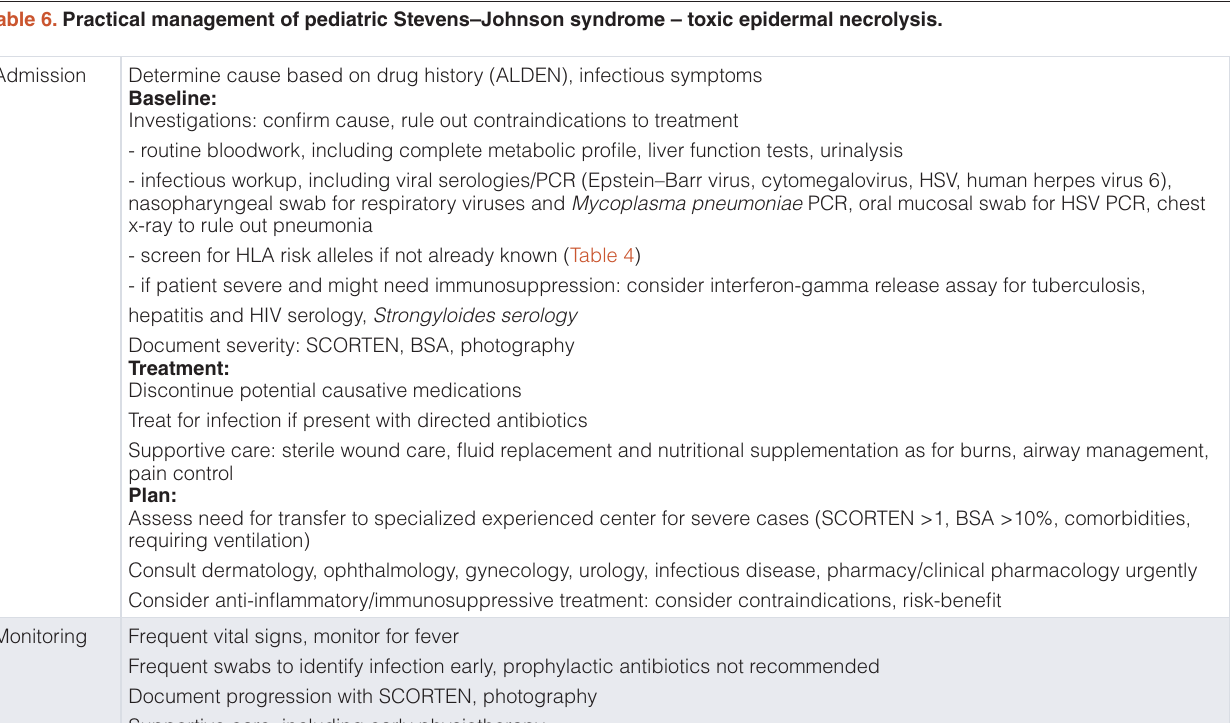
Table 6. Practical management of pediatric Stevens–Johnson syndrome – toxic epidermal